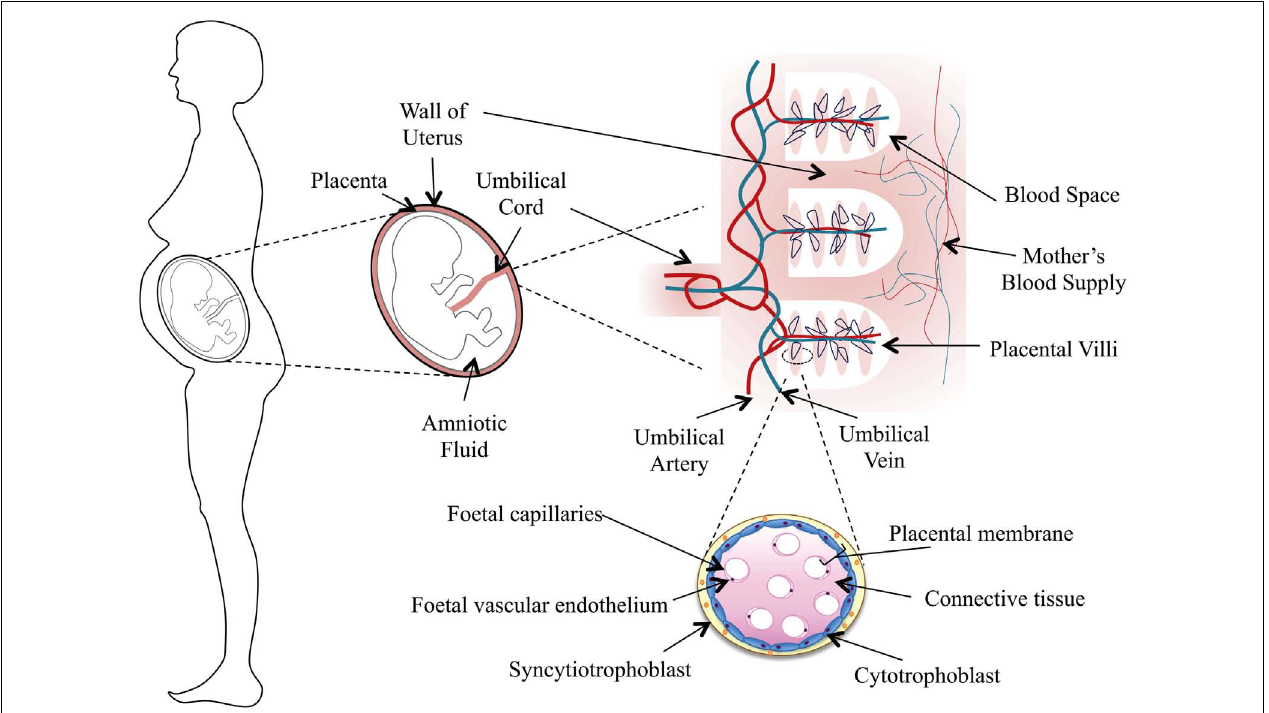
from the intervillous space across the placental barrier to the fetal capillary network that joins the umbilical vessels.The syncytiotrophoblasts, cytotrophoblasts, and connective tissue that make up the placental membrane are the key structures of the placental